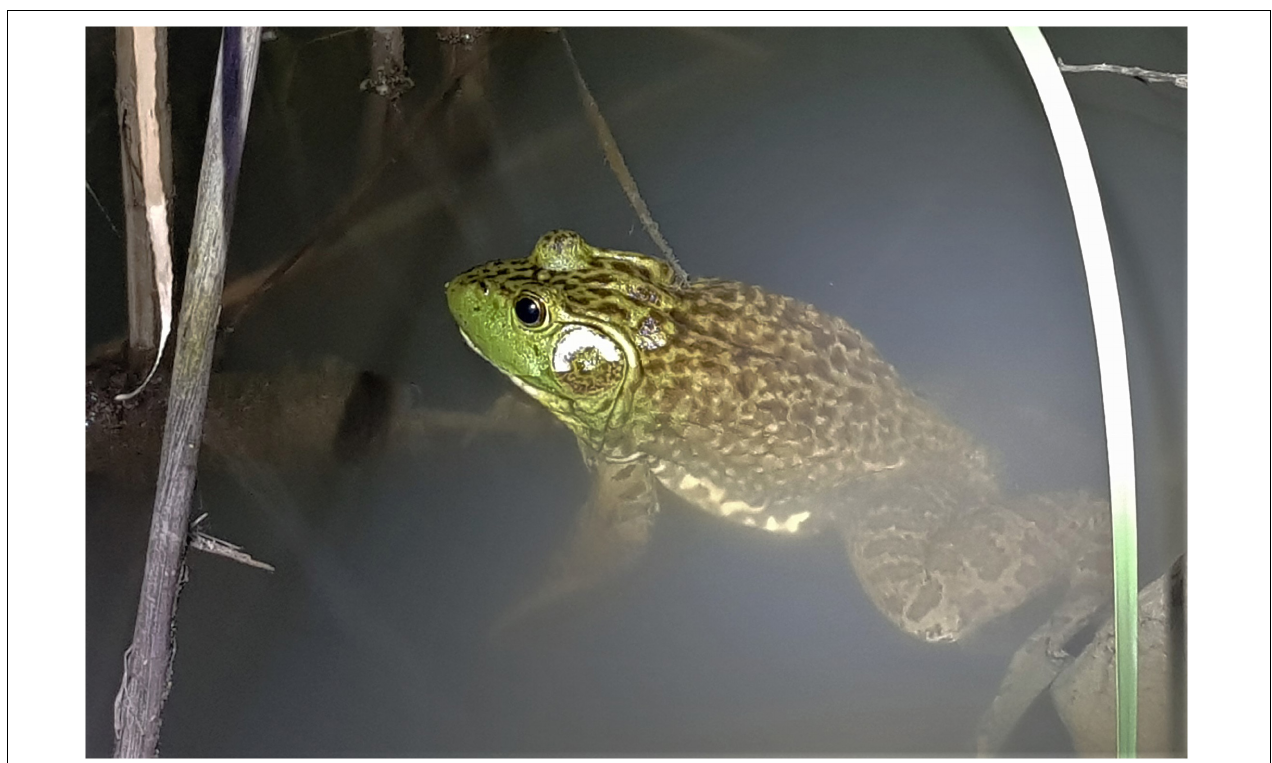
FIGURE 1 | Lithobates catesbeianus , the American bullfrog, in the wild in the Republic of Korea. This species has been introduced in the country where it has established feral population that have a significant negative impact on local species, likely resulting in the extirpation of some Hylid